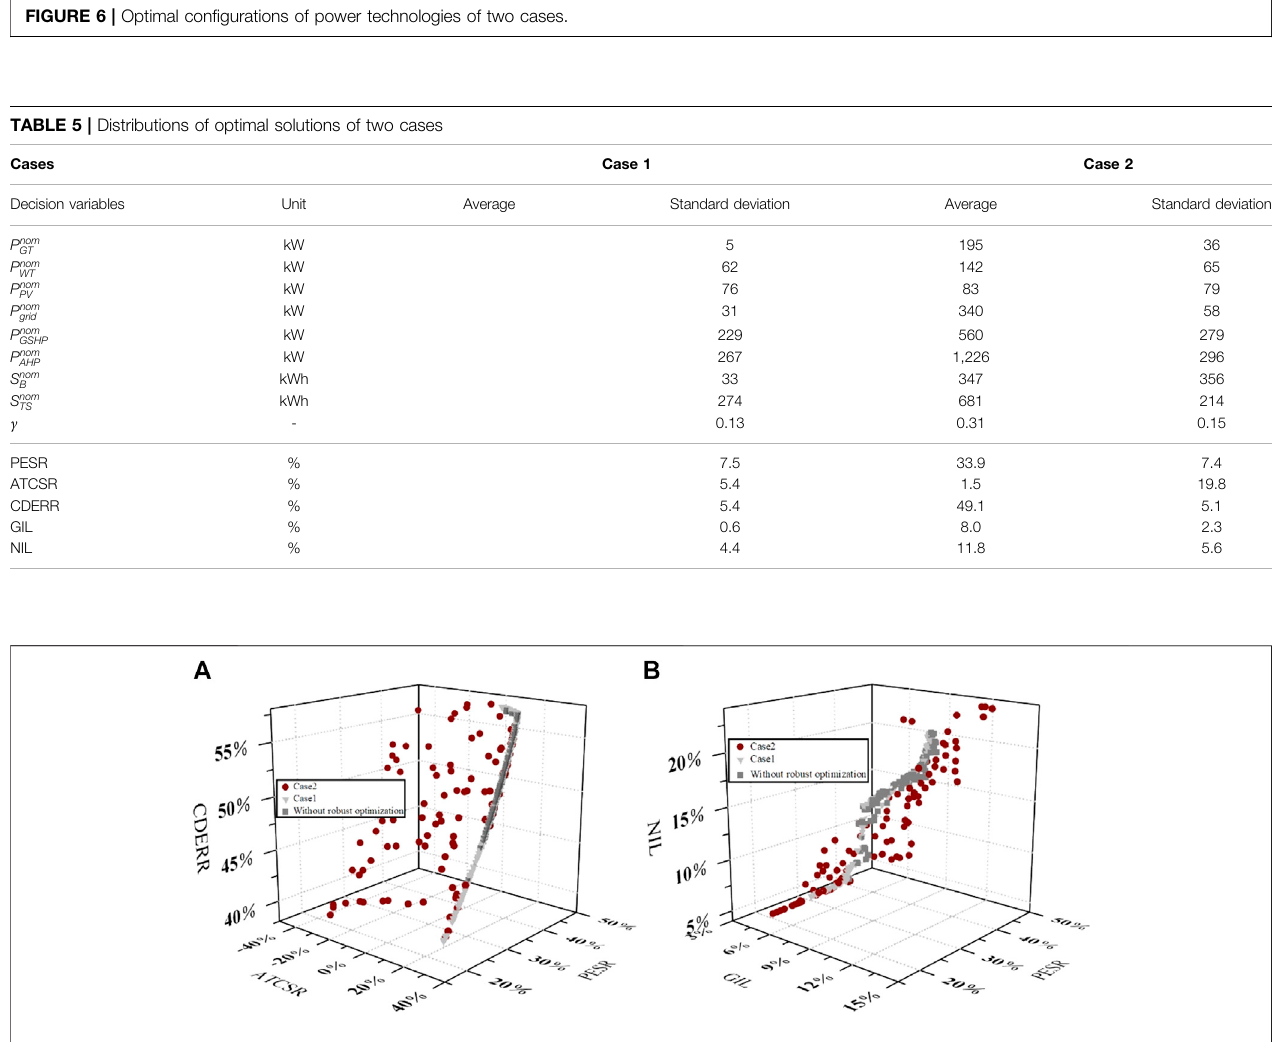
FIGURE 7 | Comparisons of Pareto frontiers of optimal systems considering different objectives.